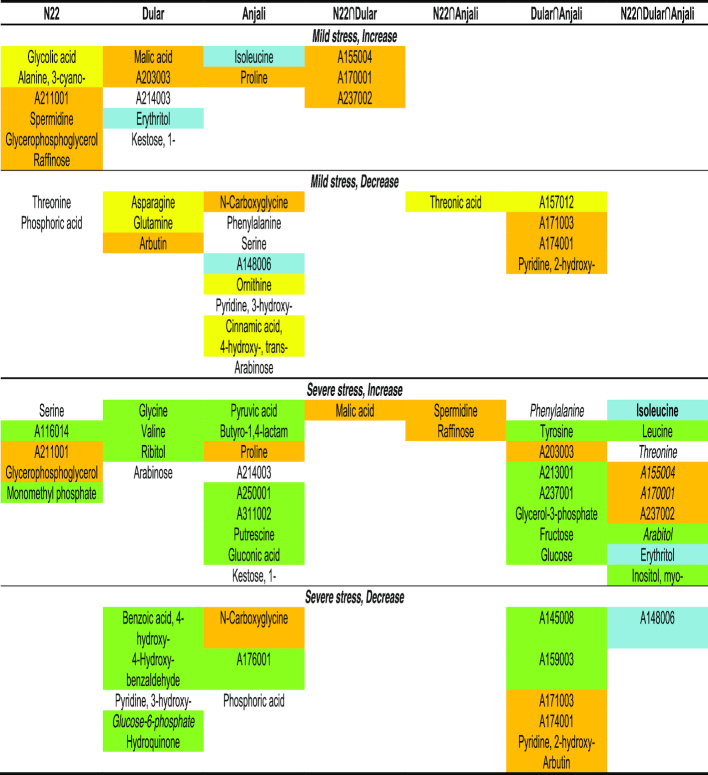
Common and cultivar-specific stress-responsive metabolites in flowering spikelets. Metabolites correspond to the numbers in the Venn diagrams in Fig. 9. Comparisons between mild and severe stress are color-coded: orange: common response irrespective of stress intensity; yellow: mild stress−specific; green: severe stress−specific; blue: rapid response in susceptible cultivars, delayed response in the tolerant cultivar N22. Common responses of flowering spikelets (Fig. 10) and developing seeds (Fig. 11C) during severe stress are indicated by font style: boldface: same response among all cultivars between the 2 organs; italics: cultivar-specific with similar responses in the same cultivars across the 2 organs. 4-Hydroxyphenyl-β-glucopyranoside is listed as arbutin; phosphoric acid monomethyl ester as monomethyl phosphate.